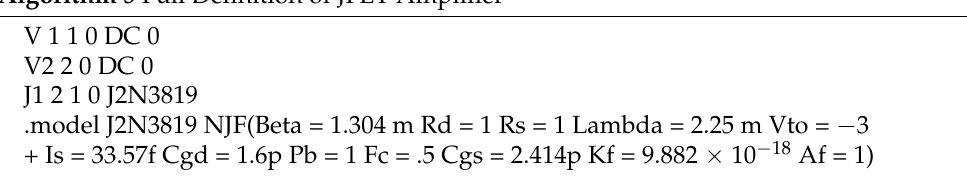
Algorithm 5 Full Definition of JFET